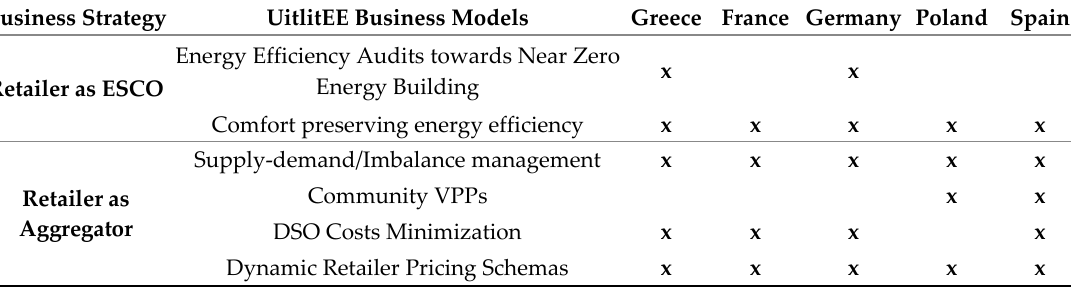
Table 1. UtilitEE Business Models per pilot site under